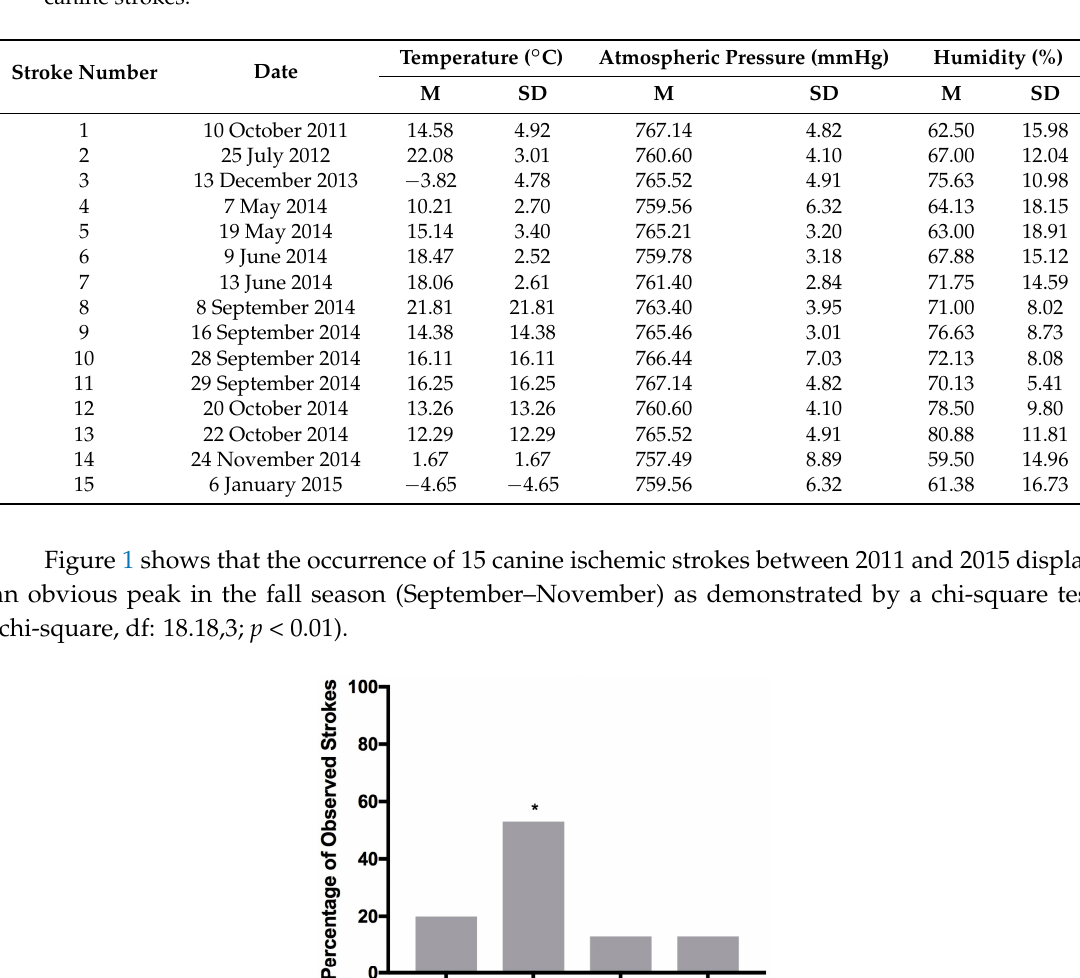
Table 2. Weather conditions at Boston Logan International Airport 8 days prior to the occurrence of 15 canine strokes.